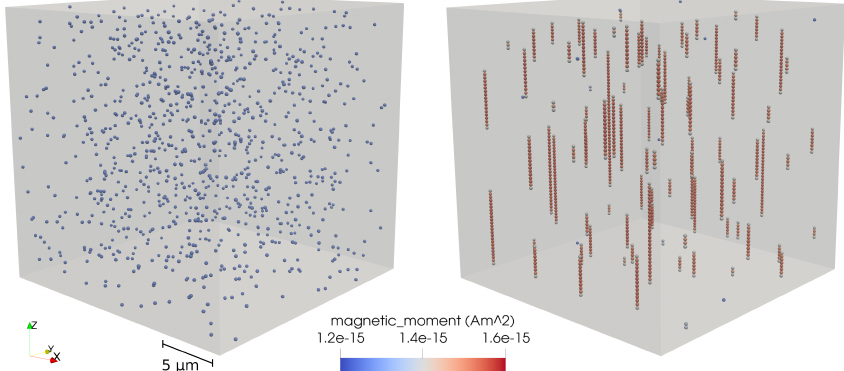
Figure 6. Aggregation procedure at α a = 1 × 10 − 3 concentration. The left picture shows the initial random particle positions, the right one shows the self-aggregated structure at t = 0.14s. The magnetic field was H = 180kA · m − 1 · e z ≈ 0.23T · e z . The particles are colourised by their magnetic moment values.